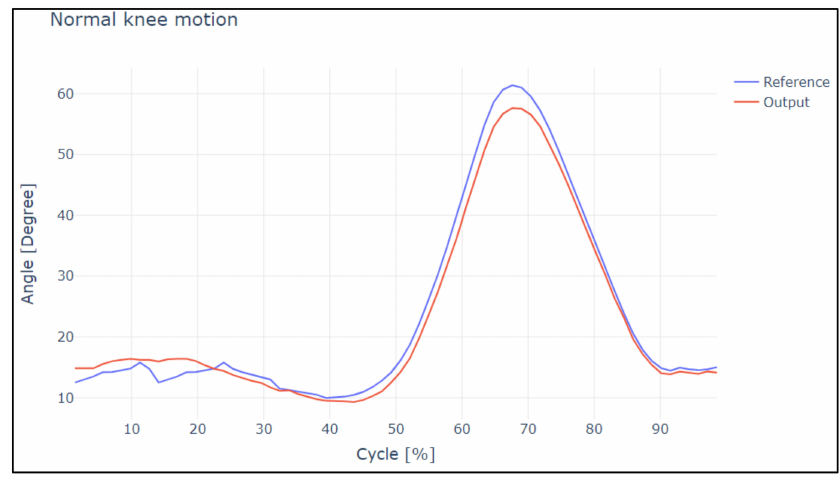
Figure 15. Reference curves vs. output during normal knee motion.